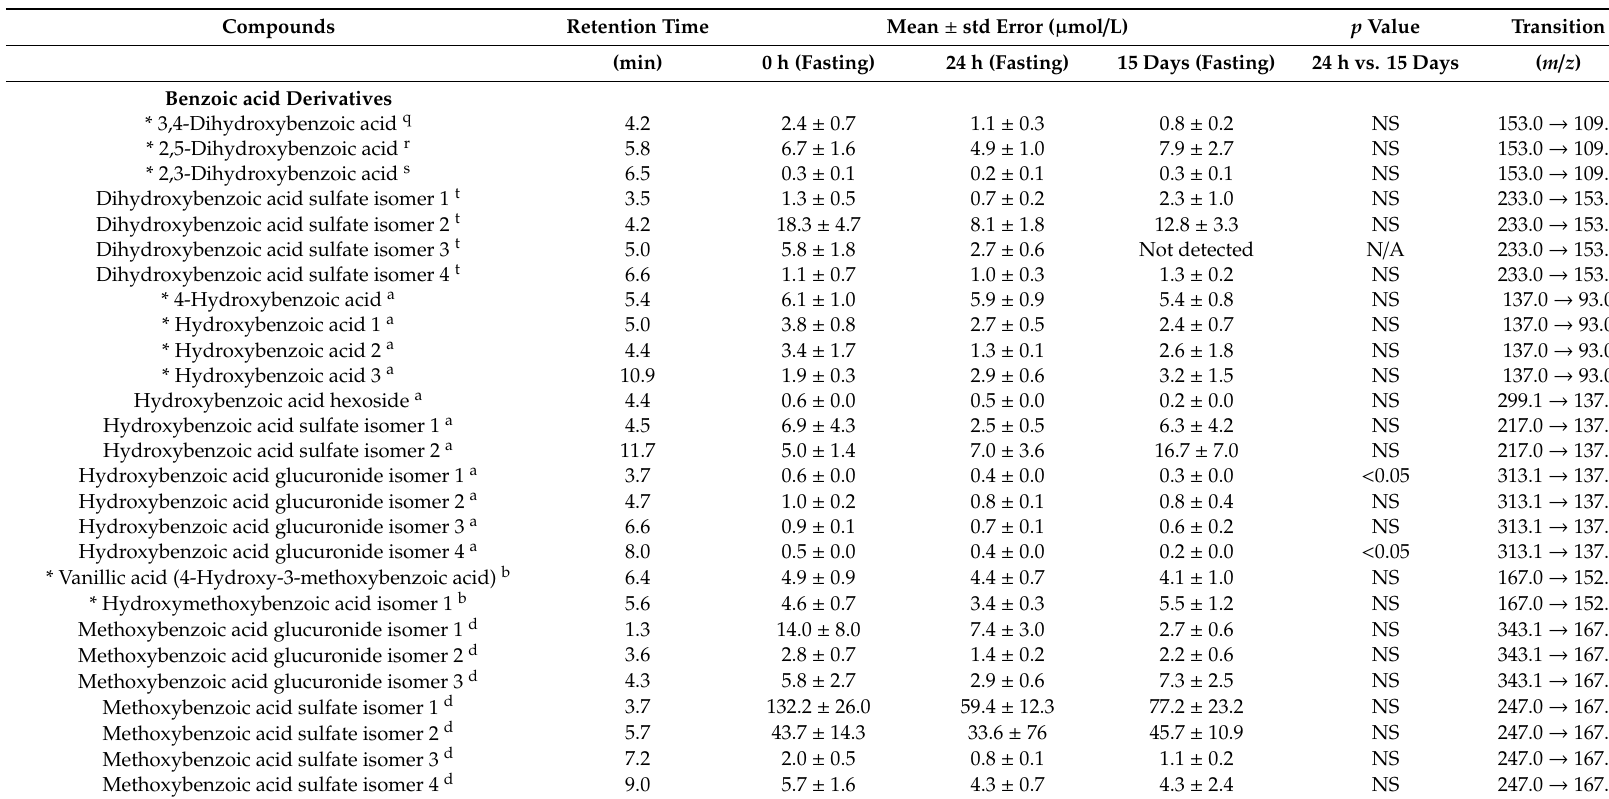
Table A2. Concentration of (poly)phenolic compounds and their metabolites in fasting urine samples: baseline (0 h, before MP beverage intake), 24 h fasting (24 h